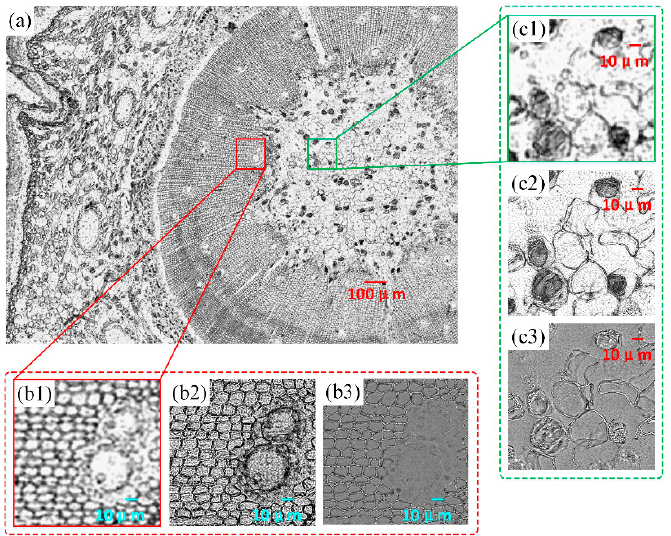
Figure 6. Experiment results of a pine stem transection specimen. ( a ) The full FOV of the pathology sample recorded with the implemented platform. ( b1 – b3 ) Enlargement, reconstructed HR intensity image, and reconstructed phase image, respectively, of a small segment located inside the red box in the original captured image. ( c1 – c3 ) Enlargement, reconstructed HR intensity image, and reconstructed phase image, respectively, of another small segment located inside the green box in the original captured image.